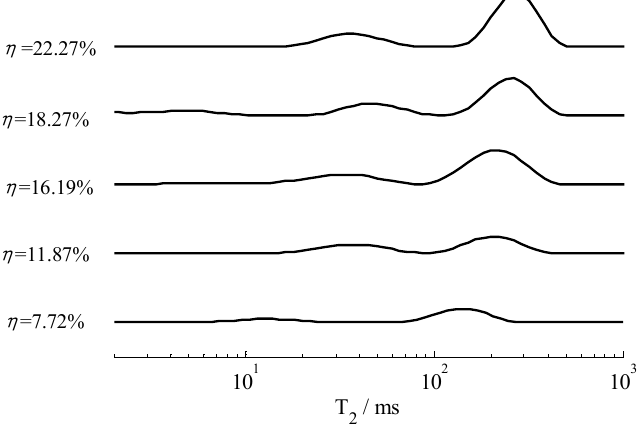
Figure 12. T 2 spectrum curves of the silica sand with different moisture Figure 12. Correspondence between the integral area of the T 2 spectrum with the moisture content of Figure 13. T 2 spectrum curves of the silica sand with different moisture content. the sandy soil.